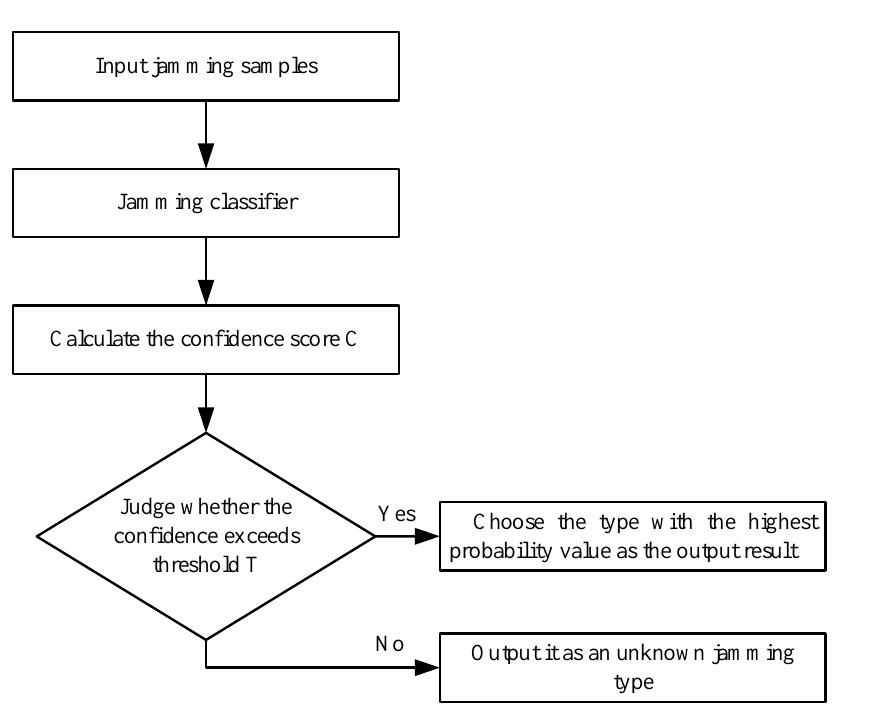
Figure 10. The testing process of OSR model based on confidence score.